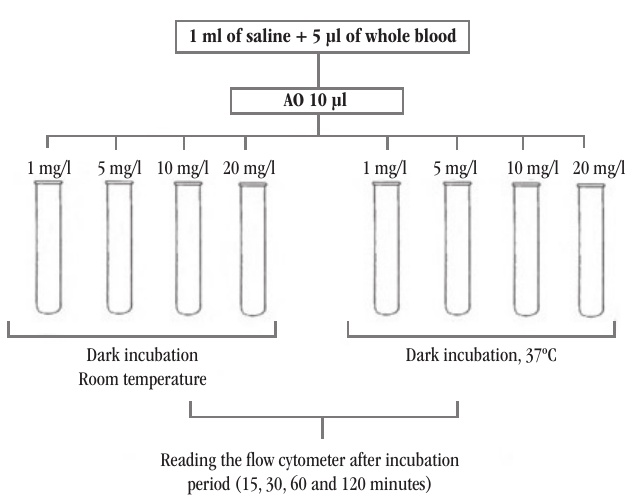
figurE 1 – Design of the experiment used to define the best concentration of AO, time and temperature of incubation, to standardize the method of FC reticulocyte counting FC: flow cytometry; AO: acridine orange.